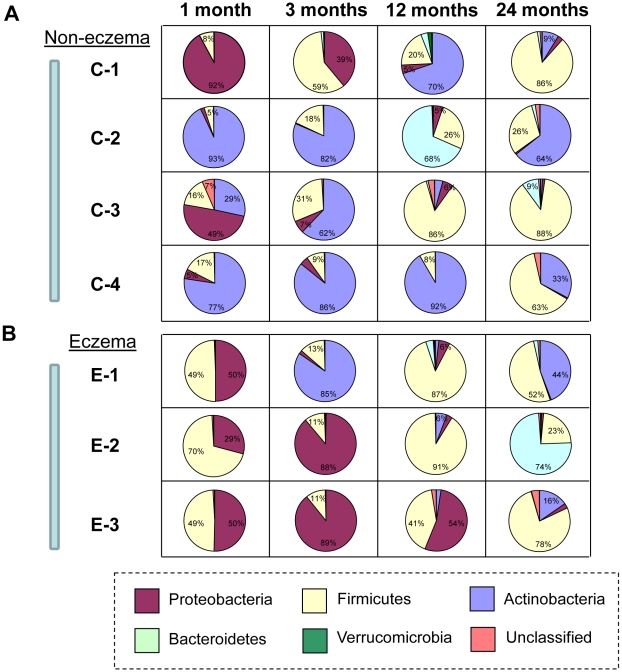
Microbial succession evaluated at phyla level with 454 pyrosequencing.(A) C-1, C-2, C-3 and C-4 are infants without eczema. (B) E-1, E-2 and E-3 are infants with eczema. The stools were comprised mainly of phyla Proteobacteria, Actinobacteria, Firmicutes, Bacteroidetes in varying abundances within each individual and across different temporal intervals. Phyla with abundances more than 5% are marked accordingly.